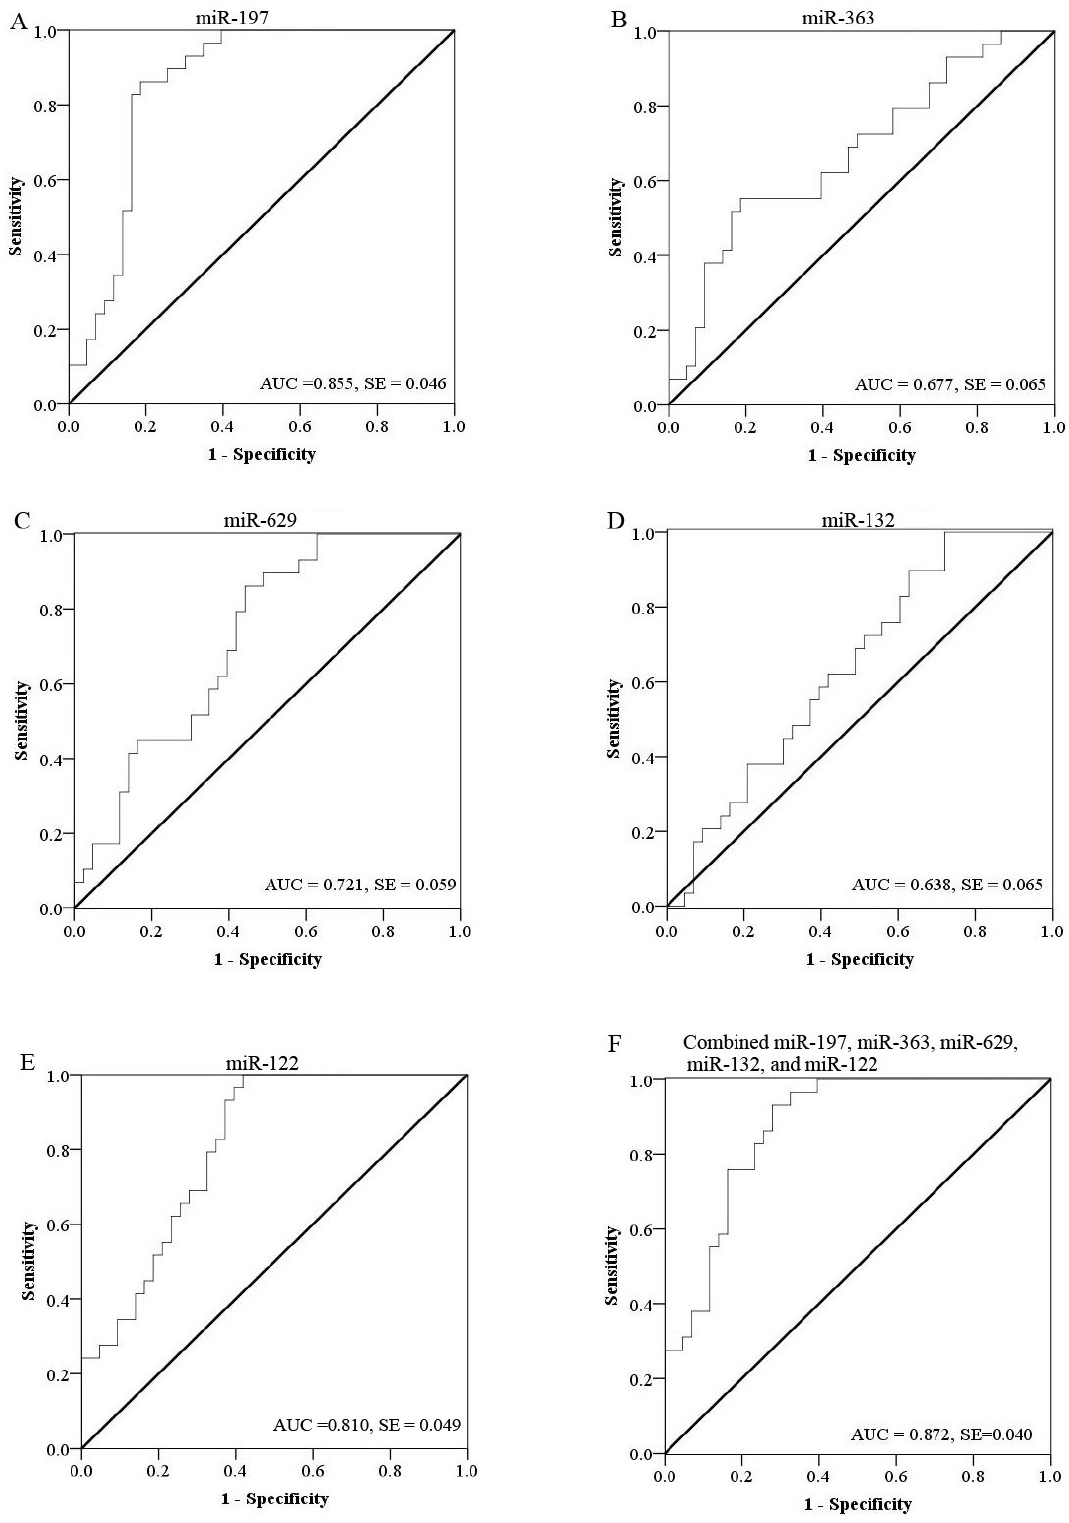
Figure 2. Receive operating characteristic (ROC) curves of differentially expressed miRNAs between varicella patients and healthy controls. ROC curves of miR-197 ( A ); miR-363 ( B ); miR-629 ( C ); miR-132 ( D ) and miR-122 ( E ) showed a moderate distinguishing efficiency. The combination of the five miRNAs showed a slightly higher AUC value of 0.872 ( F